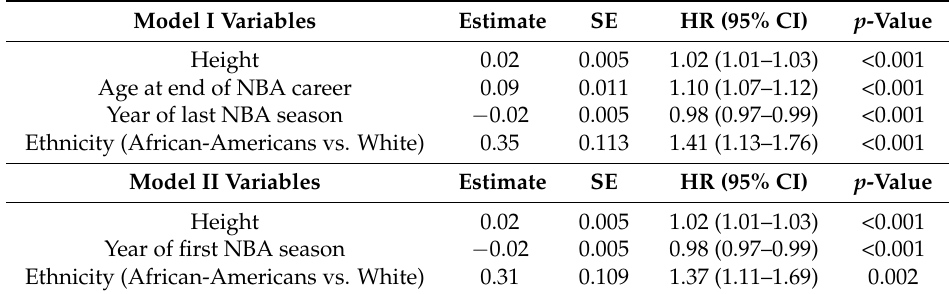
Table 2. Cox regression models to analyze factors associated with mortality among NBA players during the period 1946–2015. The response variable in Model I is the time elapsed from the end of the NBA career until death. The response variable in Model II is age at death.